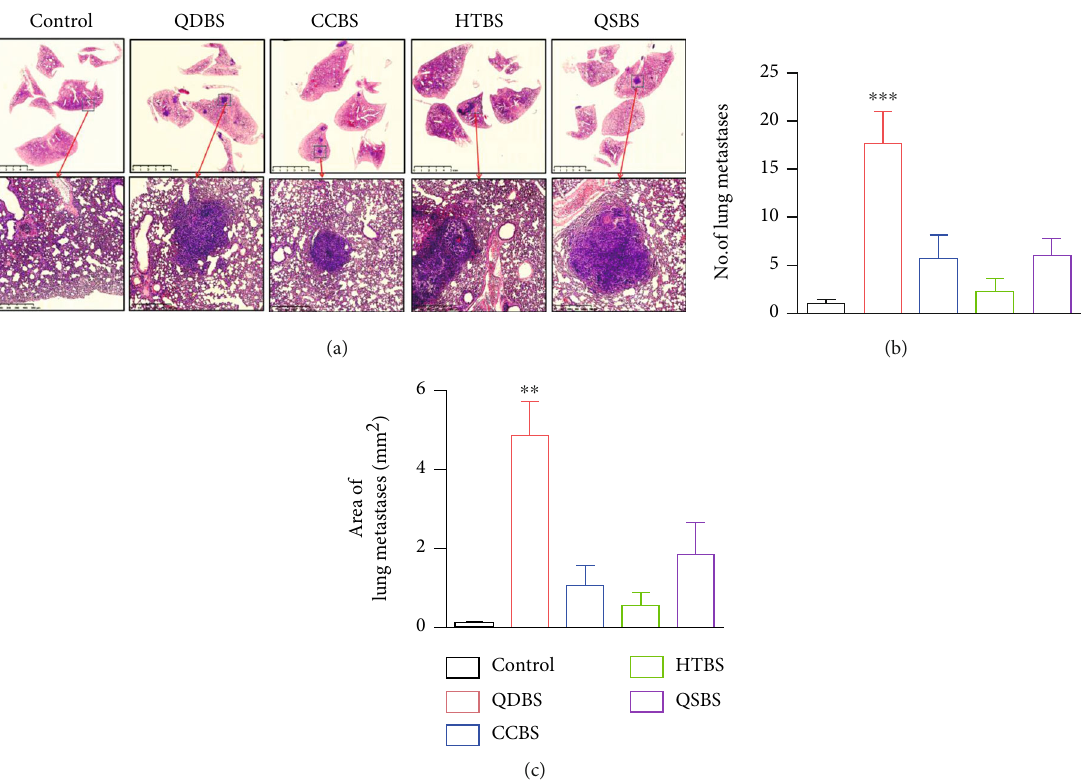
Figure 3: E ff ect of blood stasis syndrome on lung metastasis in mice. (a) Representative image of pathological hematoxylin and eosin staining in the lung tissue of the control and blood stasis syndrome groups. Scale bar: 5mm and 500 μ m. (b) Quantitative statistics of the metastatic lesion number in the lung tissue. (c) Quantitative statistics of the metastatic lesion area in the lung tissue. ∗∗ P < 0 : 01 and ∗∗∗ P < 0 : 001 , vs.